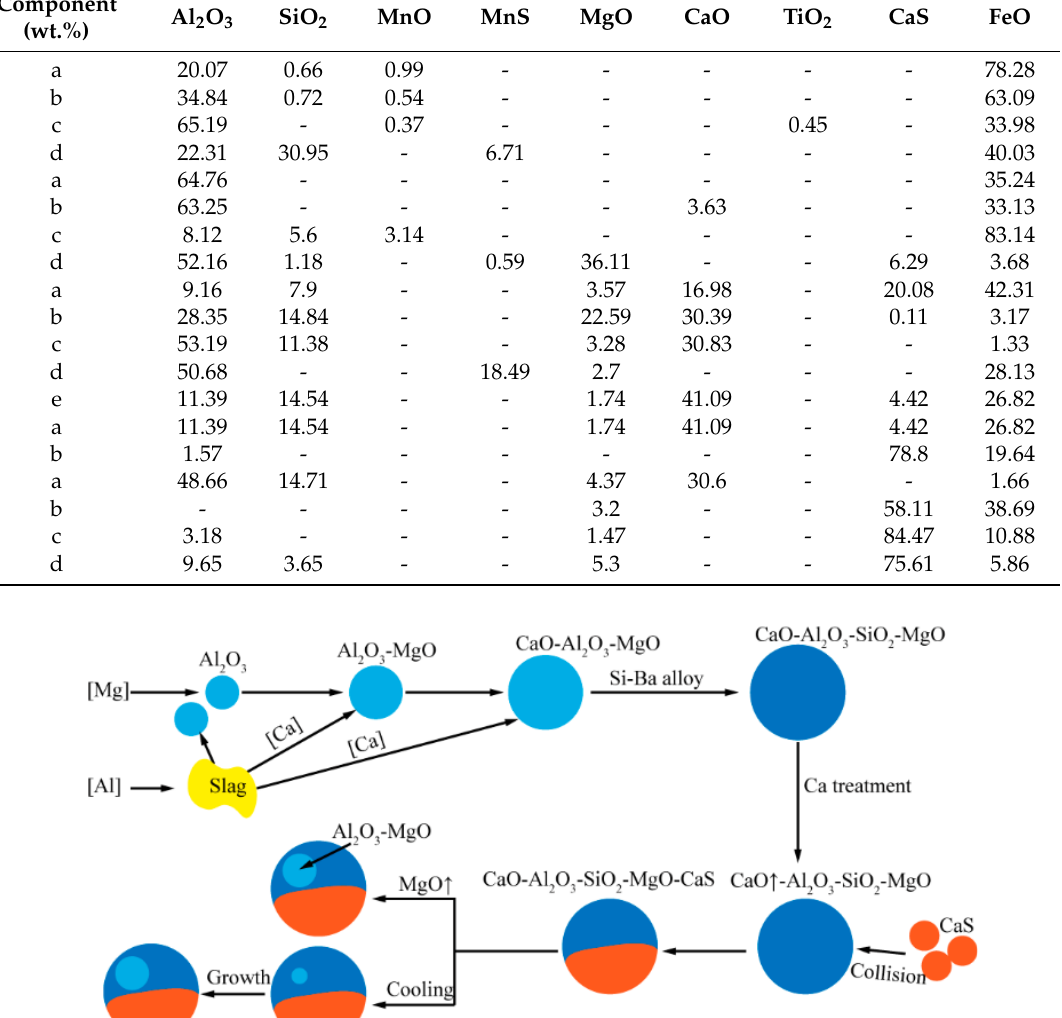
Figure 8. Mechanism of inclusion evolution of 27SiMn steel.